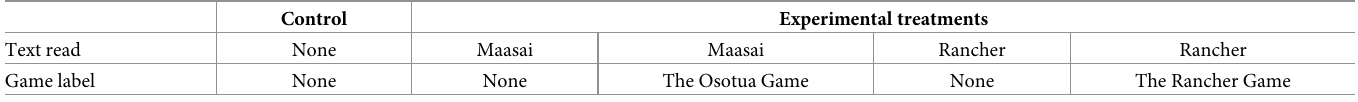
Table 2. Experimental